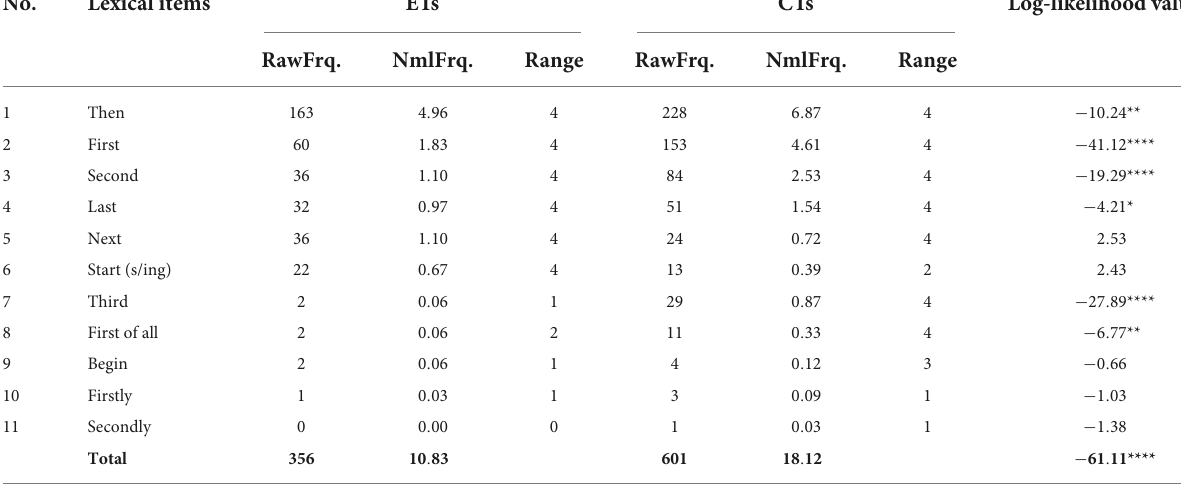
TABLE 6 Summary of sequencing in both